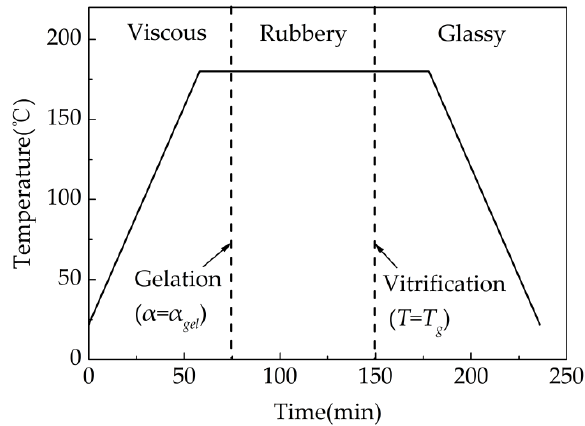
Figure 1. Various stages of composite properties during curing.